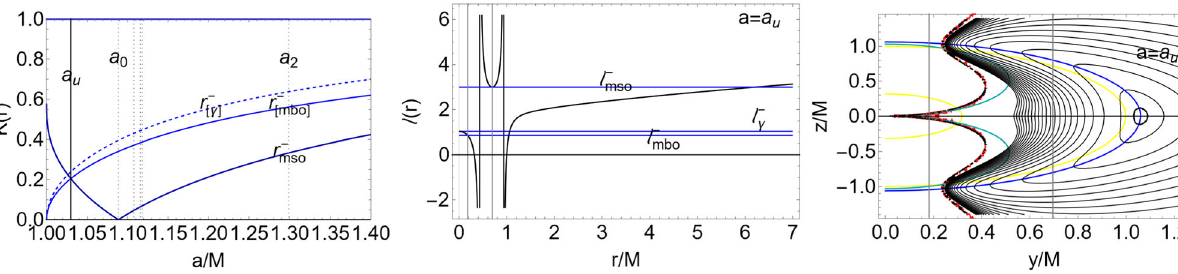
Fig. 9 Analysis of the double co-rotating toroids with (cid:6) = (cid:6) − , possi- ble for (cid:6) > (cid:6) − mso > 0 in a ∈] M , a 0 [ . For (cid:6) − > 0 inversion points are only for space-like particles with ( E < 0 , L < 0 ) in the conditions of Sec. (C). Here the most general solutions r ± (cid:2) are shown not consider- ing the further constraints of Sect. 3.2. Spins { a 0 , a 1 , a 2 } are defined in Table 2 and a u = 1 . 03 M . Notation ( mso ) is for marginally stable orbit, ( mbo ) is for marginally bounded orbit, (γ) is for marginally cir- cular orbit. Radius r + (cid:11) = 2 M is the outer ergosurface on the equatorial plane. Left panel: function K ( r ) ≡ V ef f ((cid:6)( r )) ( V ef f is the fluid effec- tive potential) as function of the spin a / M , evaluated for the radii of